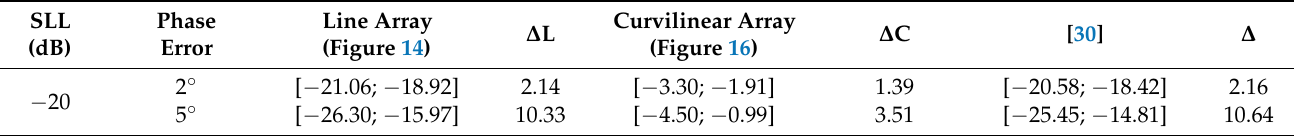
Figure 16. Power pattern under different excitation phase tolerances (Plane E, Dolph–Chebyshev excitation, the tolerance of MC method is ±2°). 3.5. Verification of Conformal Arrays Interval Analysis Because there is no comparable interval analysis example for a spherical CAA, the interval results of the linear array on the spherical surface were compared with the results of the plane linear array and the MC method. The radius of the spherical substrate is 500 mm and its ideal power pattern and the pattern with excitation amplitude and phase error are shown in Figures 15 and 16. Table 2 was compared with the example with the ampli- tude error interval in [28]. The comparison conditions in the two works are the same, i.e., SLL = − 10 dB, Dolph–Chebyshev excitation is applied, and the amplitude error ratios are 1%, 5%, and 10%, respectively. A spherical CAA significantly increased the sidelobe. Comparing the interval width of this method and RIA [28], the two results are of the same order of magnitude, which proves that the data calculated by the proposed method are reasonable. Table 3 was compared with the example with the phase error interval in [30]. The comparison conditions in the two works are the same, i.e., SLL = − 20 dB, Dolph–Cheby- shev excitation is applied, and the phase error is 2 deg and 5 deg. The interval width be- tween the method in this study and RIA [31] was compared. Although the interval width obtained by the proposed method is less than that of the RIA [31], it is still of the same